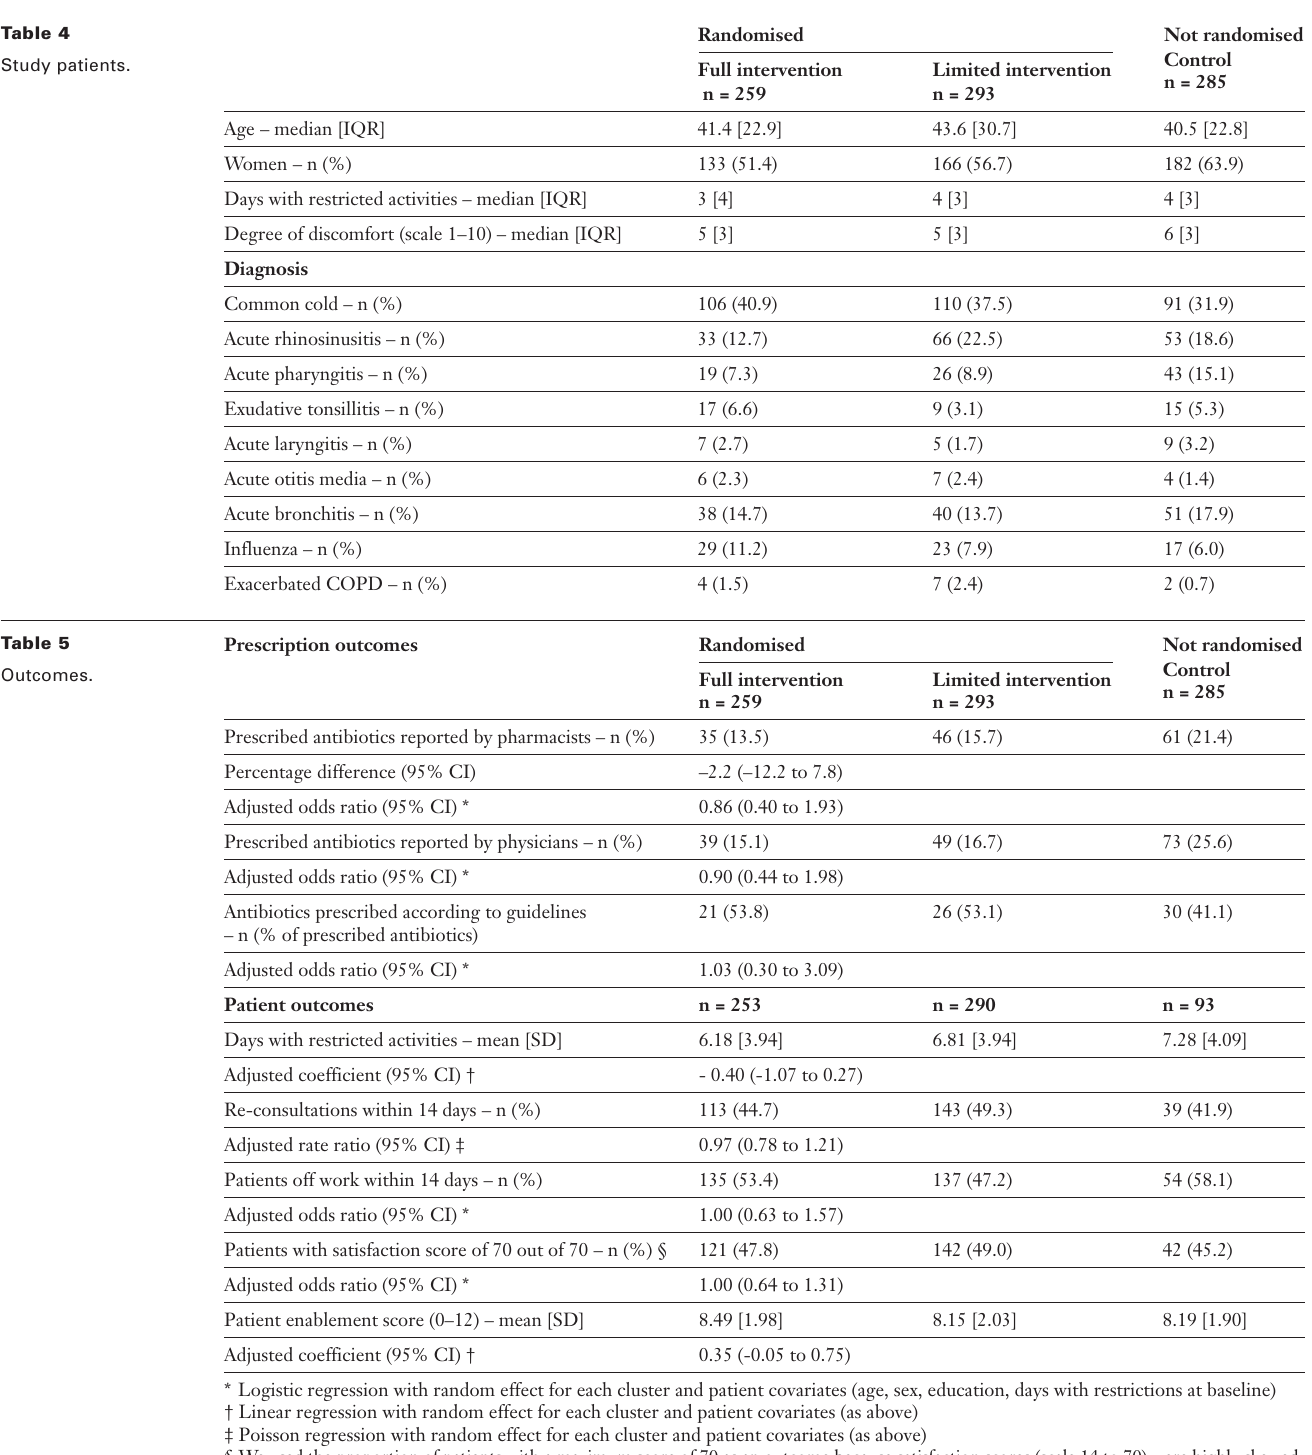
SWISS MED WKLY 2006;136:241–247 · www.smw.ch